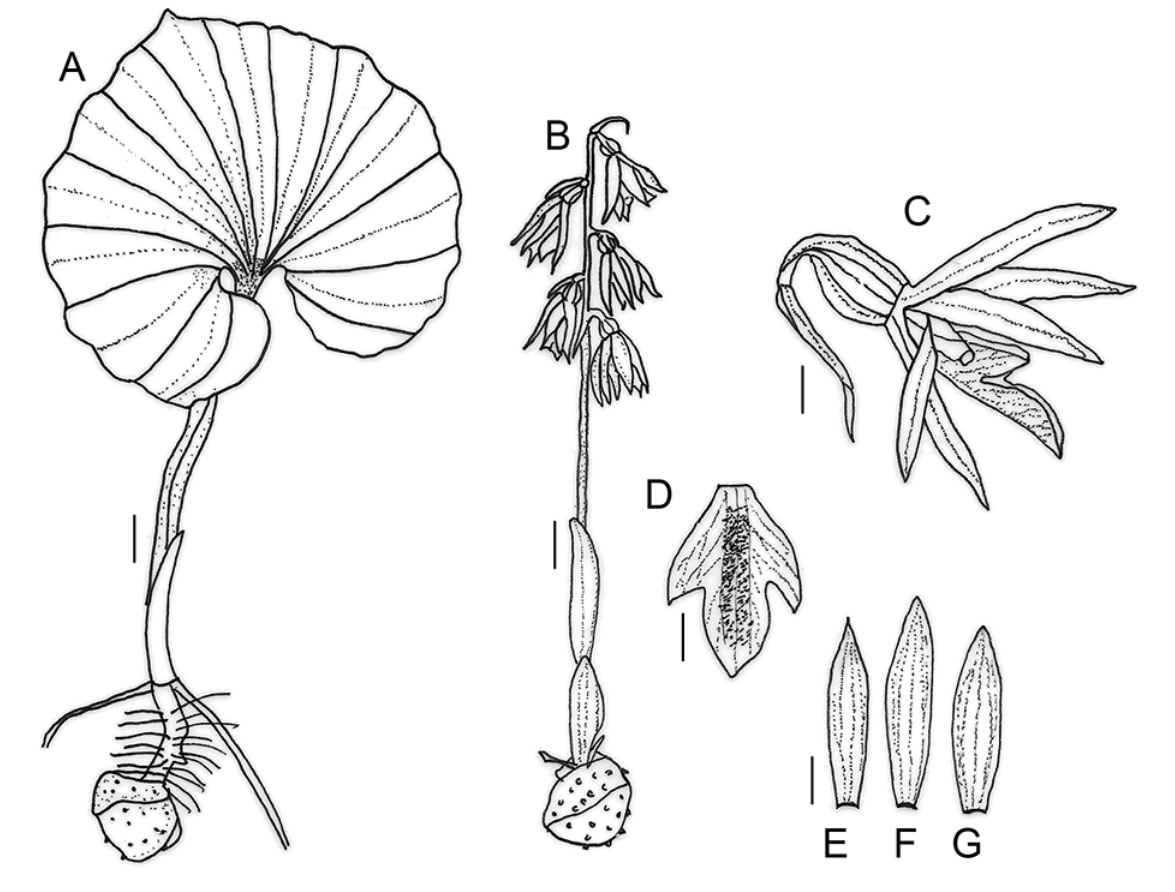
Figure 3 Nervilia aragoana . ( A ) Habit in the leafy stage. ( B ) Inflorescence. ( C ) Single flower. ( D ) Lip. ( E ) Dorsal sepal. ( F ) Lateral sepal. ( G ) Petal. Scale bars: 1 cm ( A,B ); 3 mm ( C–F ). Drawn by M.